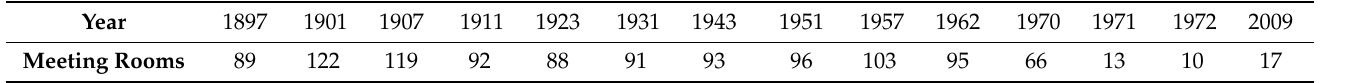
Table 4. London Exclusive (Taylor) meeting rooms in Scotland,